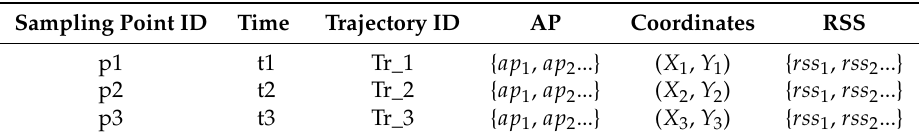
Table 1. The attributes of the sampling